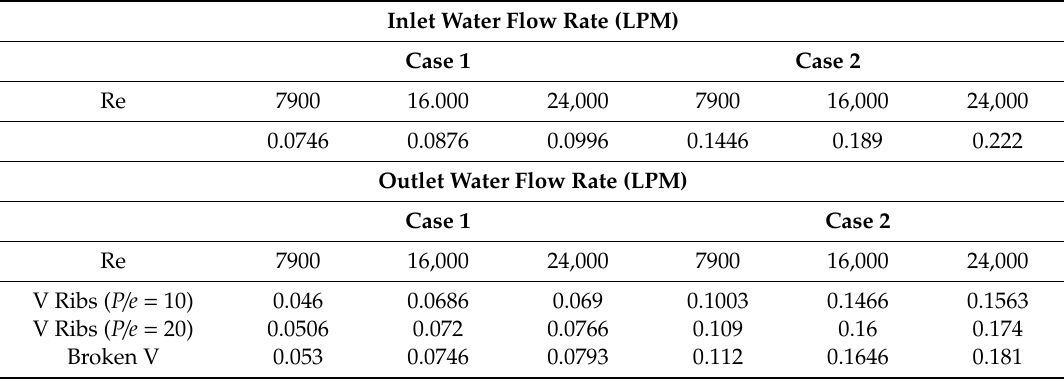
Figure 1. Schematic of the experimental setup. Table 1. Experimental parameters of the liquid flow rate (LPM) in the mist flow.